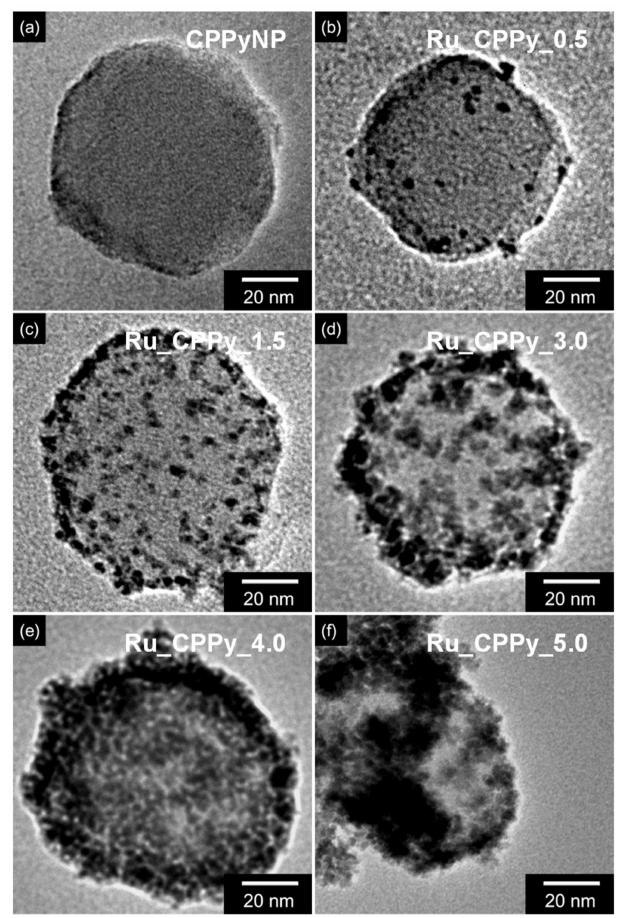
Figure 1. The transmission electron microscopy (TEM) images of Ru_CPPy with varying amounts of the Ru precursor (RuCl 3 ): ( a ) 0 mg (CPPyNP); ( b ) 0.5 mg (Ru_CPPy_0.5); ( c ) 1.5 mg (Ru_CPPy_1.5); ( d ) 3.0 mg (Ru_CPPy_3.0); ( e ) 4.0 mg (Ru_CPPy_4.0); ( f ) 5.0 mg